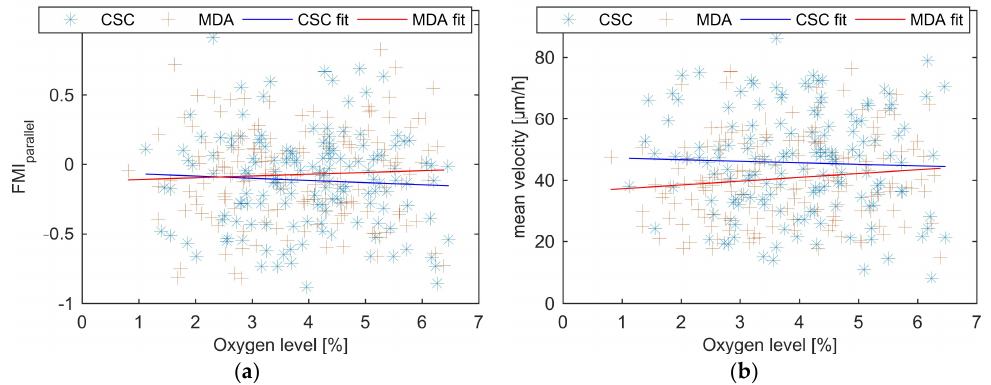
Figure A4-1. The FMI parallel and average migration velocity in the oxygen gradient, as a function of local oxygen concentration: ( a ) The FMI parallel of all tracked cells and ( b ) the average measured migration velocity of all tracked cells. For both images, the oxygen level experienced by each cell was estimated by taking its average x -position, and computing the local oxygen level at that position.